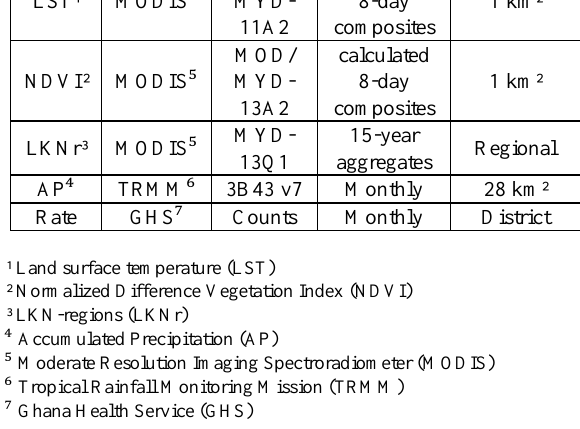
Table 2: Data sources and resolution of environmental parameters and the health